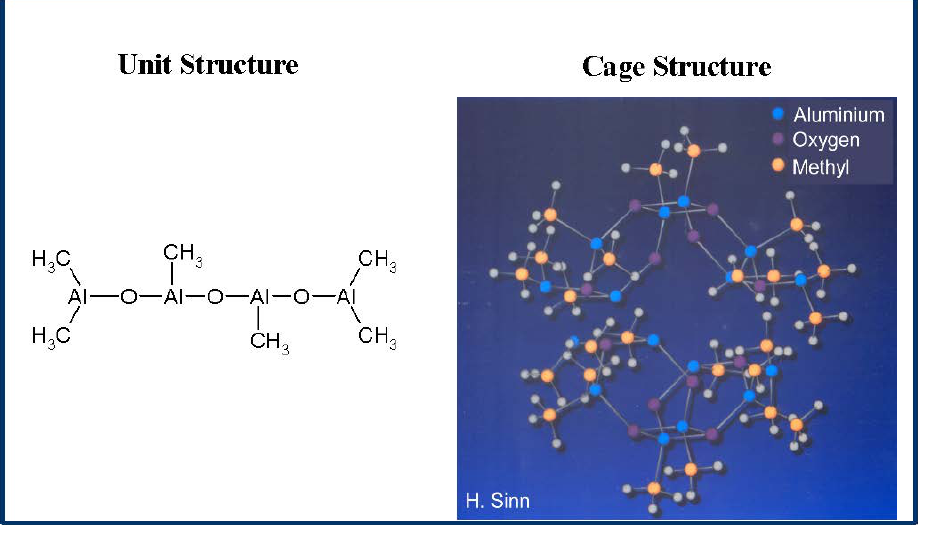
Figure 1. The main unit structure of methylaluminoxane (MAO) and the possible formation of a cage